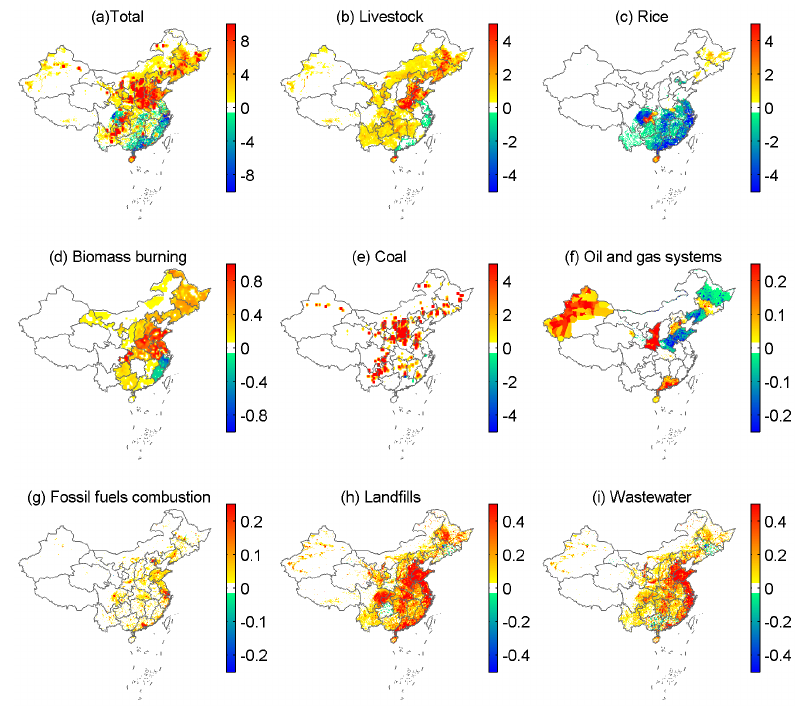
Figure 4. Spatial distribution of changes in (a) total anthropogenic CH 4 emissions and (b–i) CH 4 emissions from different source sectors in mainland China from 1980 to 2010. The unit of the color bar is gCH 4 m − 2 yr − 1 . Note that subplots have a different color scale.